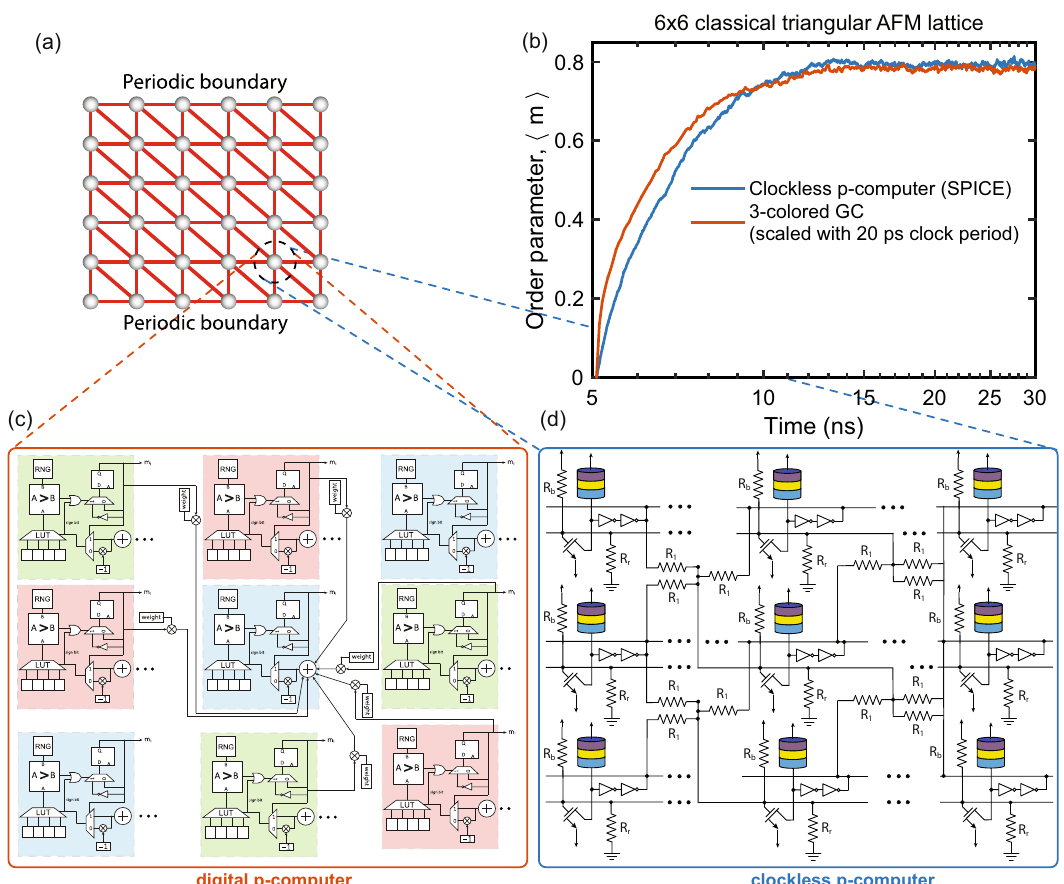
Fig. 4 Comparing digital to clockless p-computer. a A 6 × 6 antiferromagnetically (AFM) coupled triangular lattice with classical spins is shown. b The convergences of the order parameter for the lattice shown in a are plotted for two different p-computer design approaches (red solid line: graph-colored based digital design and blue solid line: nanomagnets based analog design) discussed in this work. We have used β = 2 in this example. For SPICE simulation, we averaged results over 500 different runs whereas for the graph-colored result, we averaged over 1000 different runs. c The graph-colored (GC) based digital p-computer design where the convergence is estimated from MATLAB simulations assuming c × f c ( c = 3 for triangular lattice) sweeps are collected every per second, f c being the clock frequency. d The clockless p-computer design which is simulated using SPICE